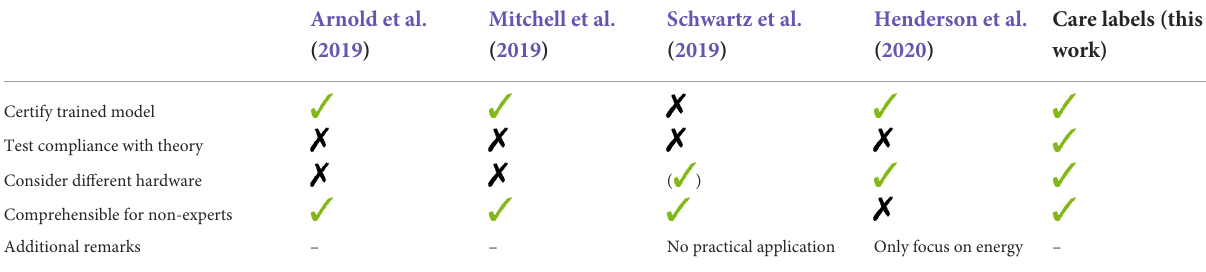
TABLE 1 Our proposed care label approach in comparison to other methods trying to certify certain aspects of the machine learning process. Arnold et al.